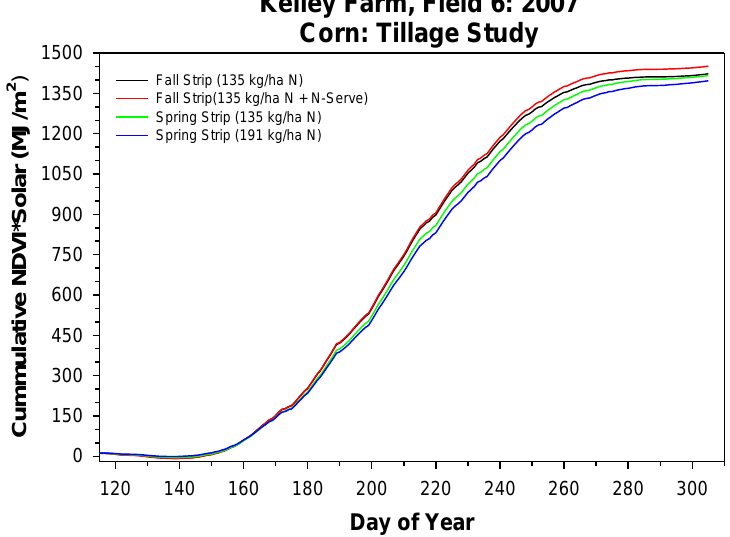
Figure 7. Cumulative intercepted solar radiation for corn in two tillage systems, fall strip and spring strip with two different N treatments in